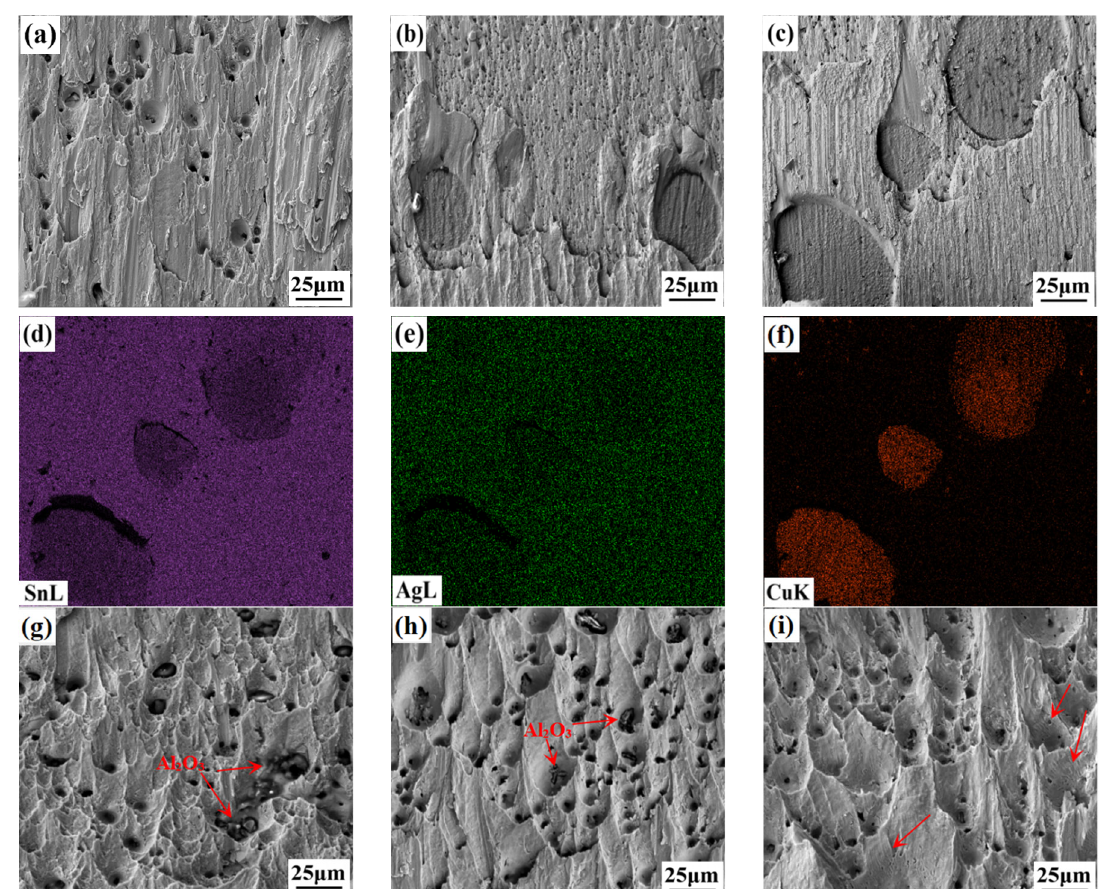
Figure 2. SEM micrograph of fracture morphology of SAC105/Cu ( a – c ) and SAC105-(nano)Al 2 O 3 /Cu ( g – i ) solder joint subjected to: 100 cycle ( a , g ); 400 cycle ( b , h ); 1000 cycle ( c , i ); Mapping image of elemental Sn: ( d ), Ag: ( e ), and Cu: ( f ).